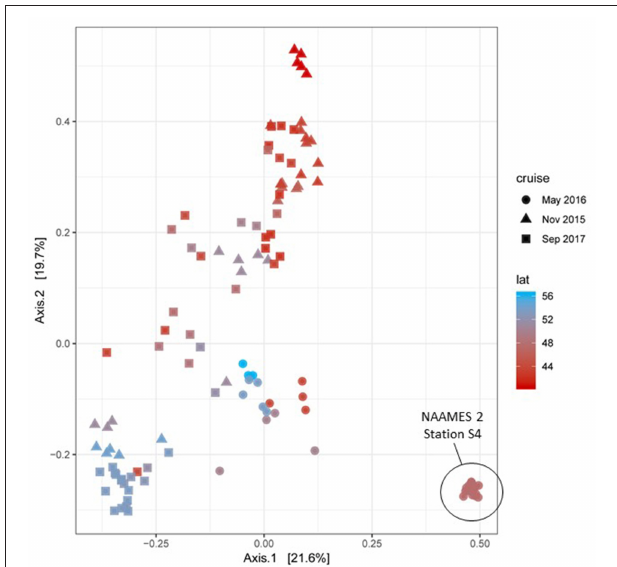
FIGURE 17 | Principal Coordinates Analysis (PCoA) ordination of NAAMES 1, 2, and 3 phytoplankton communities based on 16S rRNA amplicon profiles. Sample datasets belonging to the upper 100m of the water column for each station were used to estimate Bray-Curtis distances between them. Datasets are colored in a red-blue gradient, with the northernmost station in navy blue and the southernmost station in red. Data point shapes identify the season when the sample was taken. Triangles = NAAMES 1 (November 2015). Circles = NAAMES 2 (May 2016). Squares = NAAMES 3 (September 2017). The variance explained by each principal coordinate is expressed in percentage and indicated on the axes.